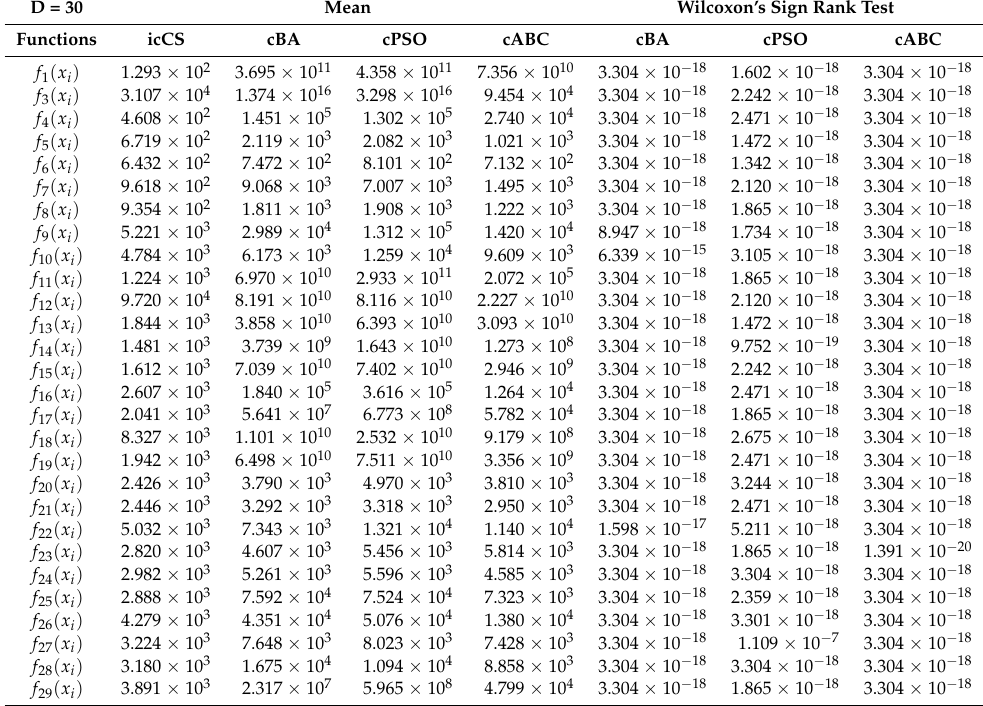
Table 6. Comparison with the average fitness function on 30D optimization among cBA, cPSO, and cABC algorithms on 28 test functions. The overall performance of each of the other algorithms was measured at a significant level α = 0.05 under the Wilcoxon’s signed rank